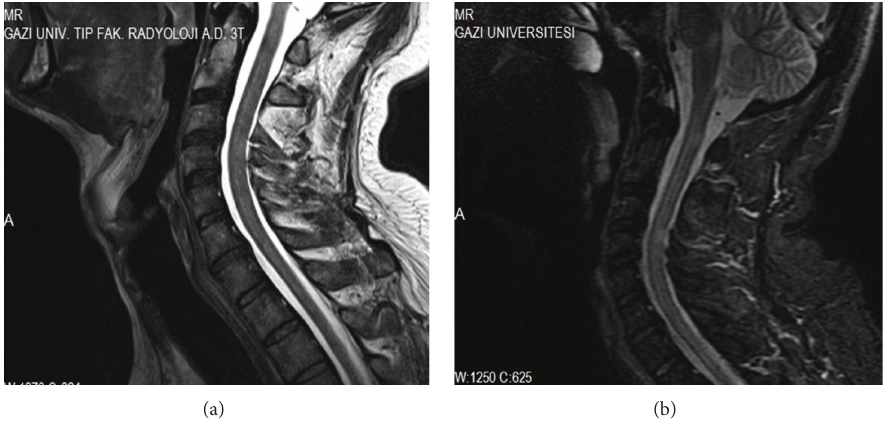
Figure 3: (a) Normal cervical MRI, T2 weighted sagittal section, (b) demyelinating posterior and posterolateral cord lesions in C1, C4, and C5-6 intervertebral disc levels and in upper thoracic segments, T2 weighted sagittal section, and control cervical MRI.